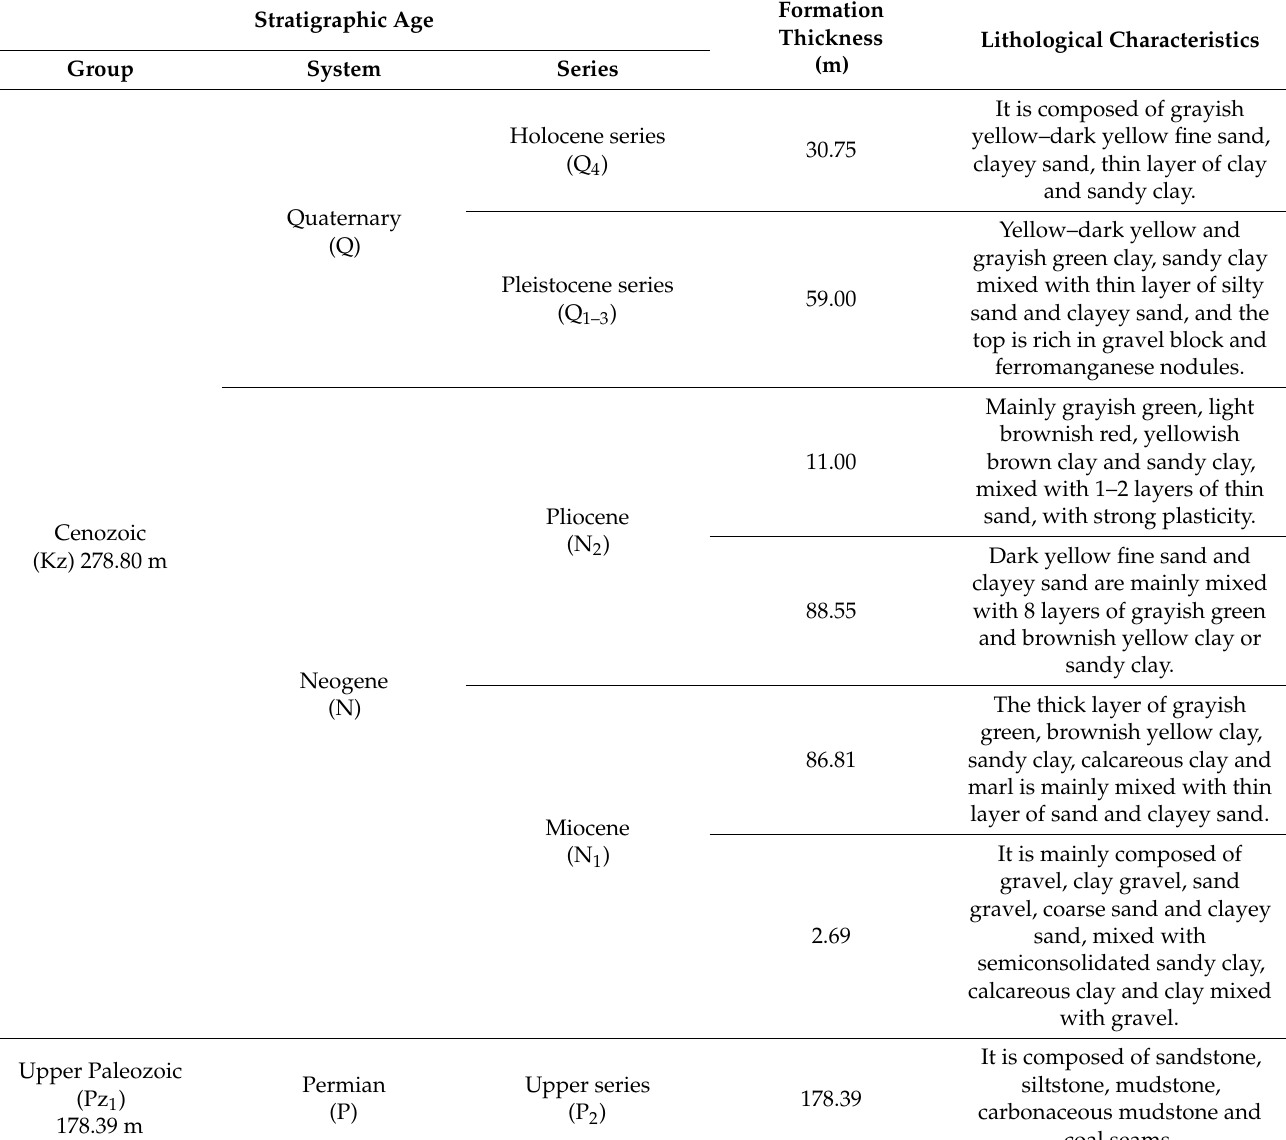
Table 1. Basic characteristics of